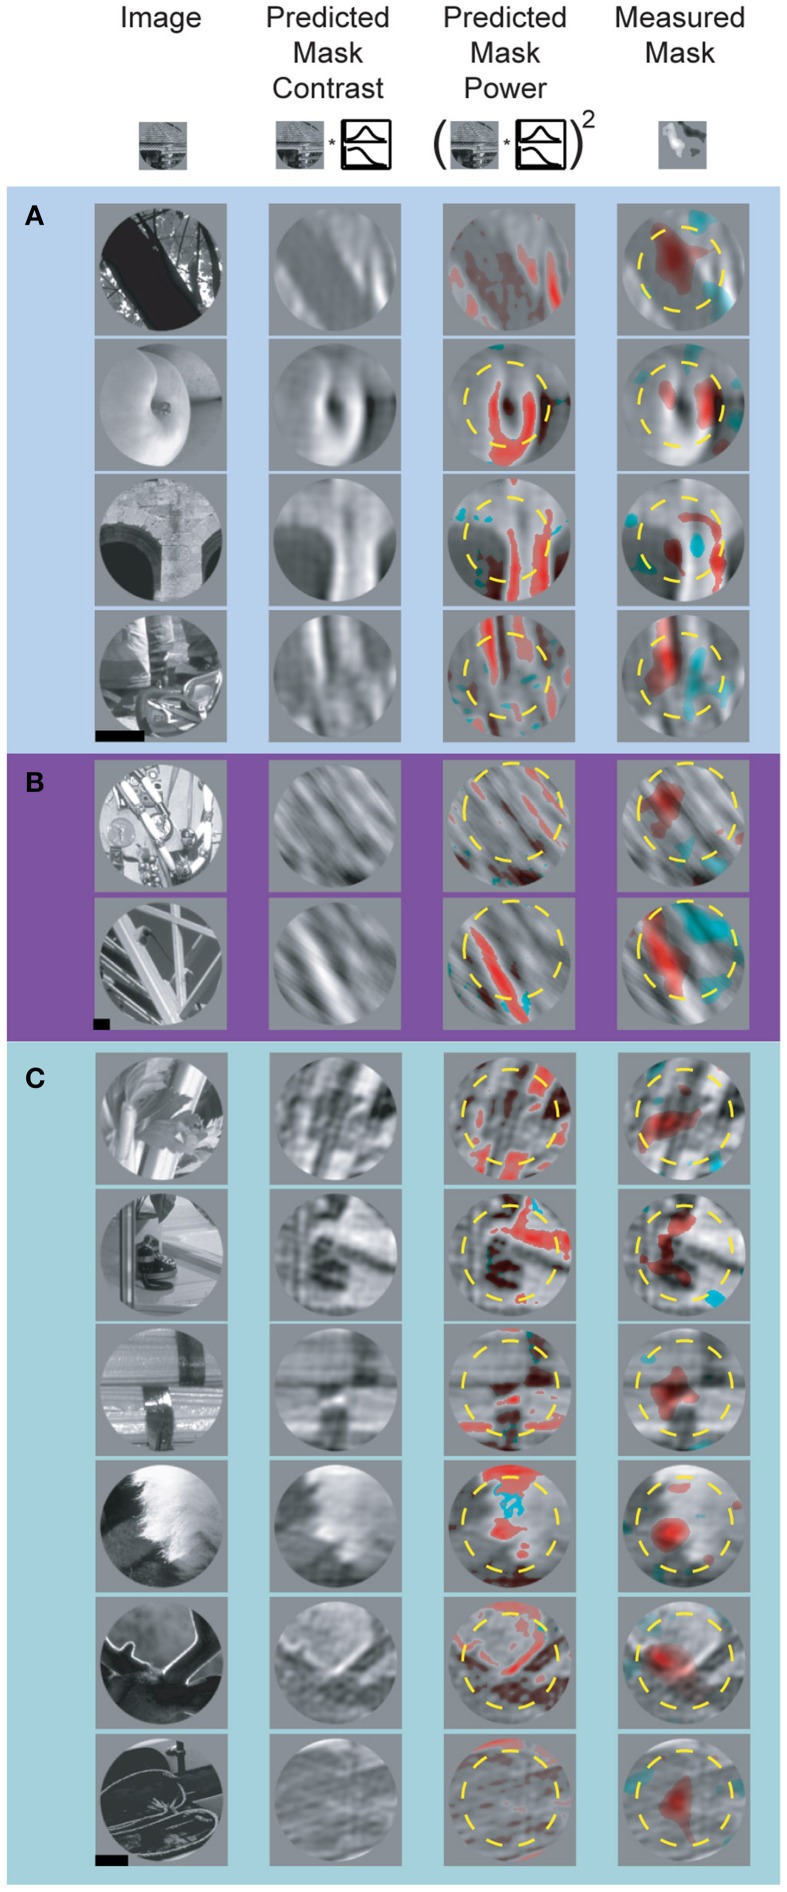
Predicted and measured spike-triggered masks for three representative V4 neurons (A–C). Left-most column shows underlying base images, two middle columns show the SRF-filtered base image and image contrast, respectively (see Materials and Methods). The right-most column shows measured spike-triggered masks for the same images. In the two right hand columns, red and blue overlay indicates excitatory and suppressive feature components of the predicted and measured masks. For display purposes, when the predicted excitatory and suppressive masks overlap, only the excitatory mask is shown. Yellow dashed circles indicate RF size and position. Scale bar = 0.5°.